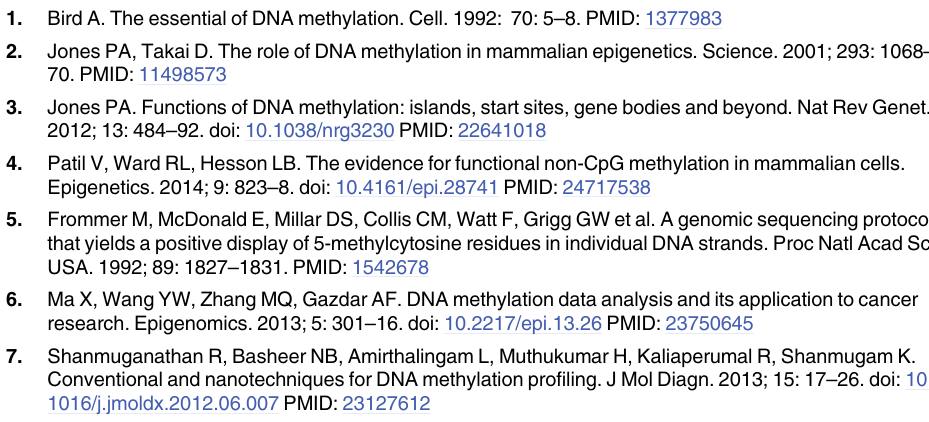
S2 Fig. (A-B). Summary of the analysis of LINE-1 methylation on DNA samples in DD study. Comparison in replicates of the colour score assignment with the two